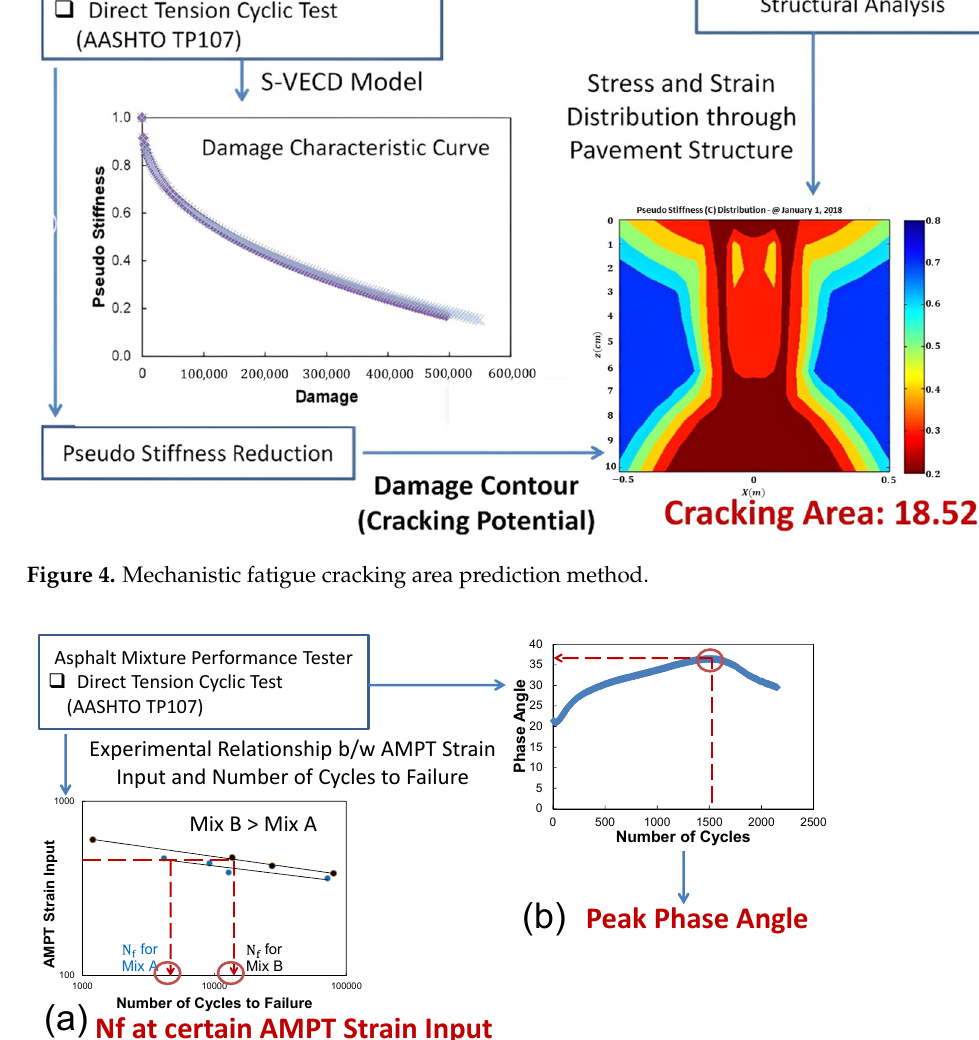
Figure 5. Fatigue cracking index method without mechanistic analysis.